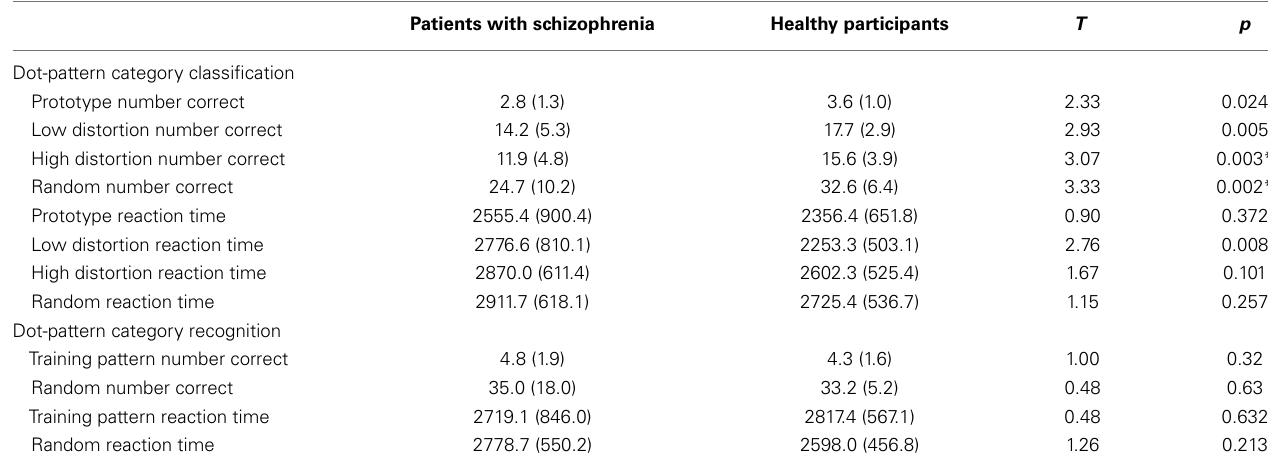
Table 3 | Mean dot-pattern category classification and recognition learning scores and standard deviations (in parentheses) for patients with schizophrenia and healthy participants.